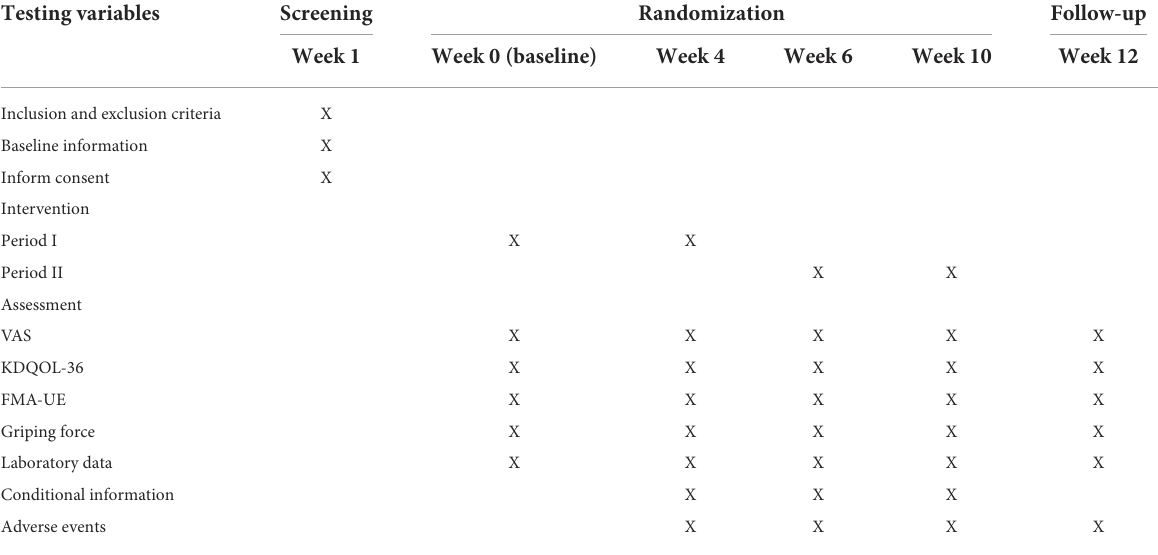
TABLE 1 Summary of collected data at each time point according to SPIRIT 2013